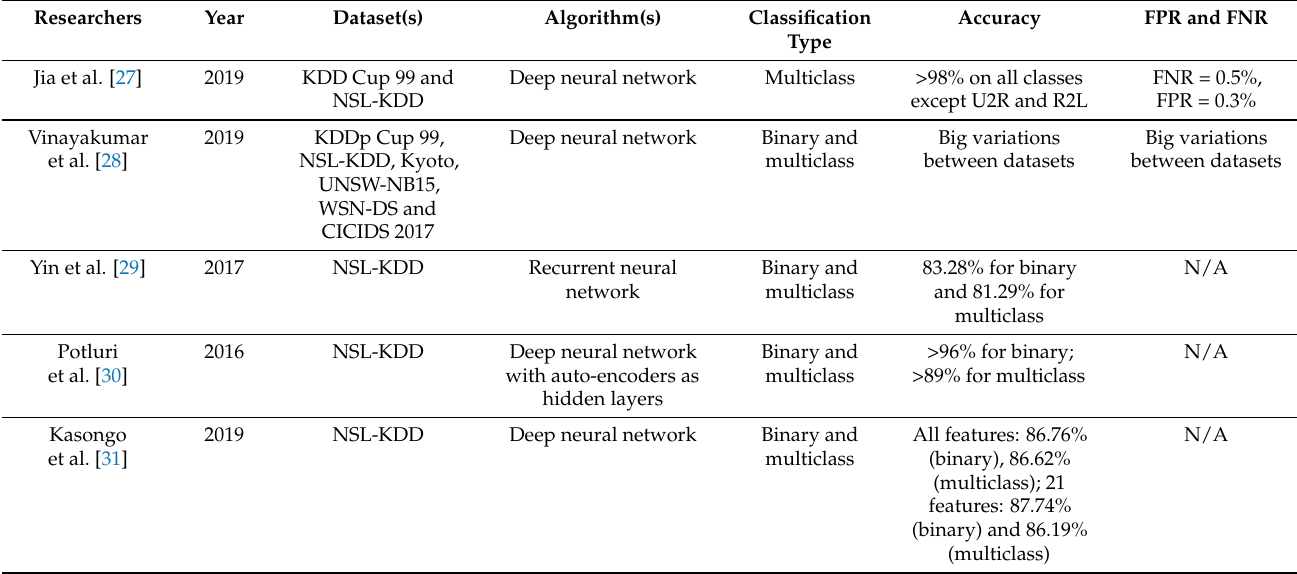
Table 3. Summary and comparison of related